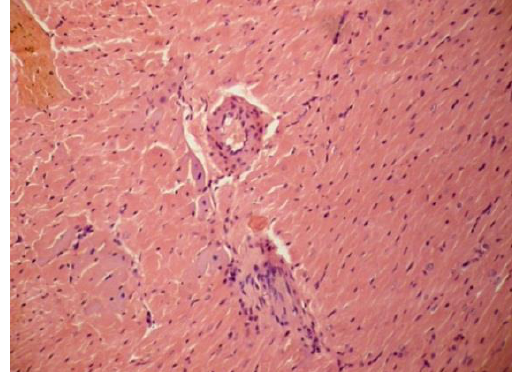
Fig. 9. SHR rat ventricular myocardium. Combined long- term therapy (ramipril and corvitin). Staining with hema- toxylin and eosin. Eye. 10×. Lens. 10×. Fig. 6. Cortical substance of the SHR rats’ kidney. Com- bined long-term therapy (ramipril and corvitin). Minor atrophy of the renal tubules. Staining with hematoxylin and eosin. Eye. 10×. Lens. 10×.